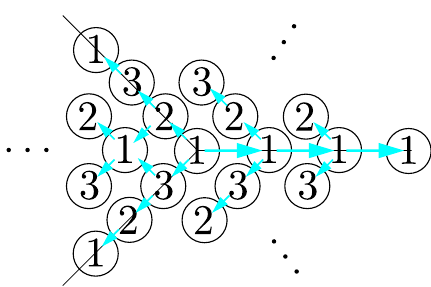
. Light blue arrows express bonds between atoms, 2 | 1